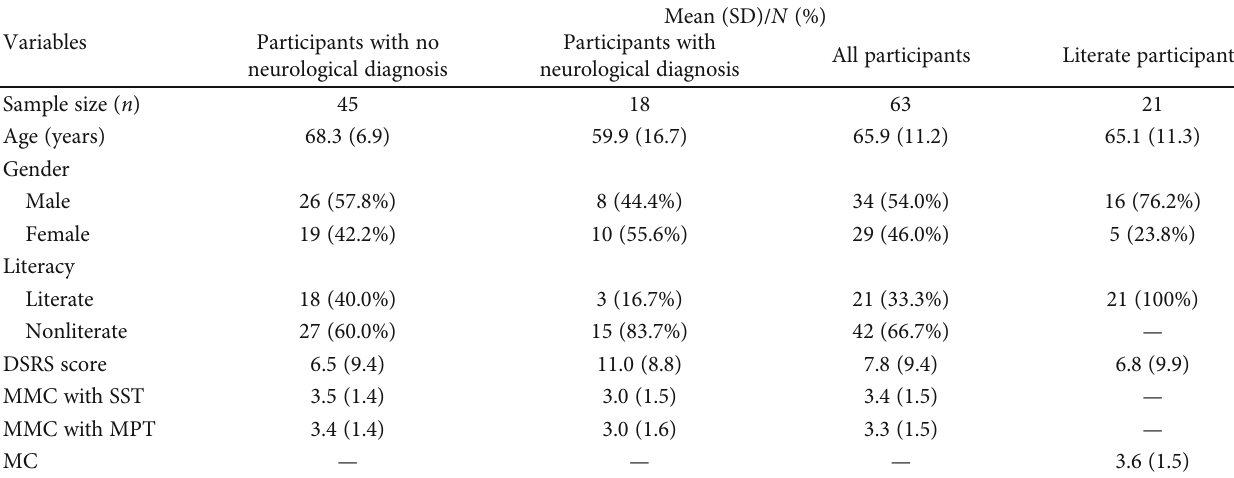
Table 1: Demographic and clinical characteristics of the participants.